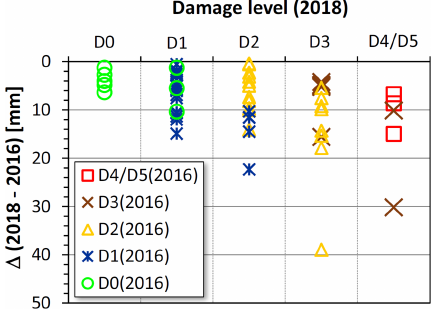
Figure 6. Building damage evolution (2016–2018) vs. increase of (cid:49) in the same time